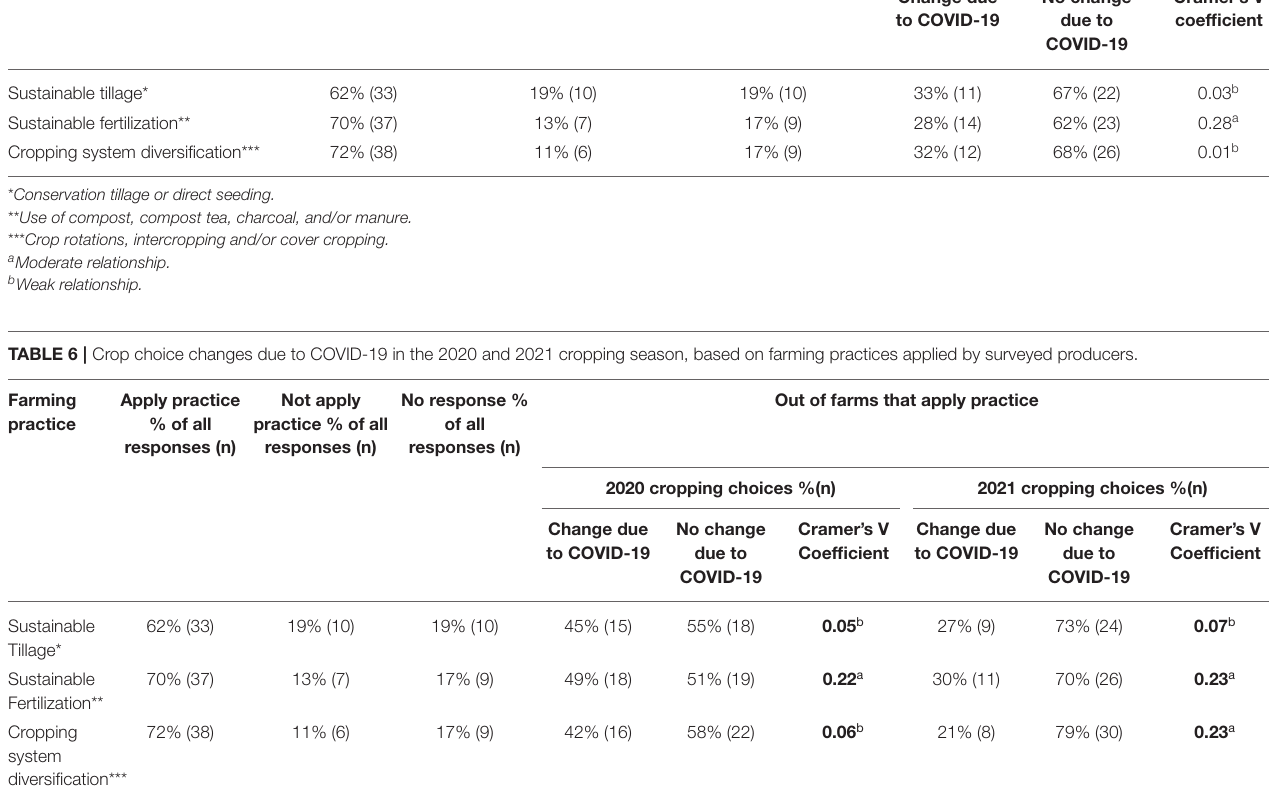
Sustainable tillage*